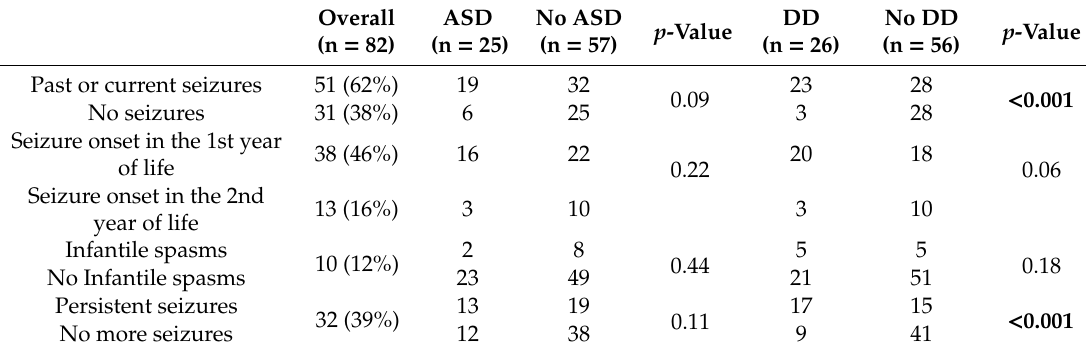
Table 2. Epilepsy characteristics of the 82 patients at the final follow-up at two years of